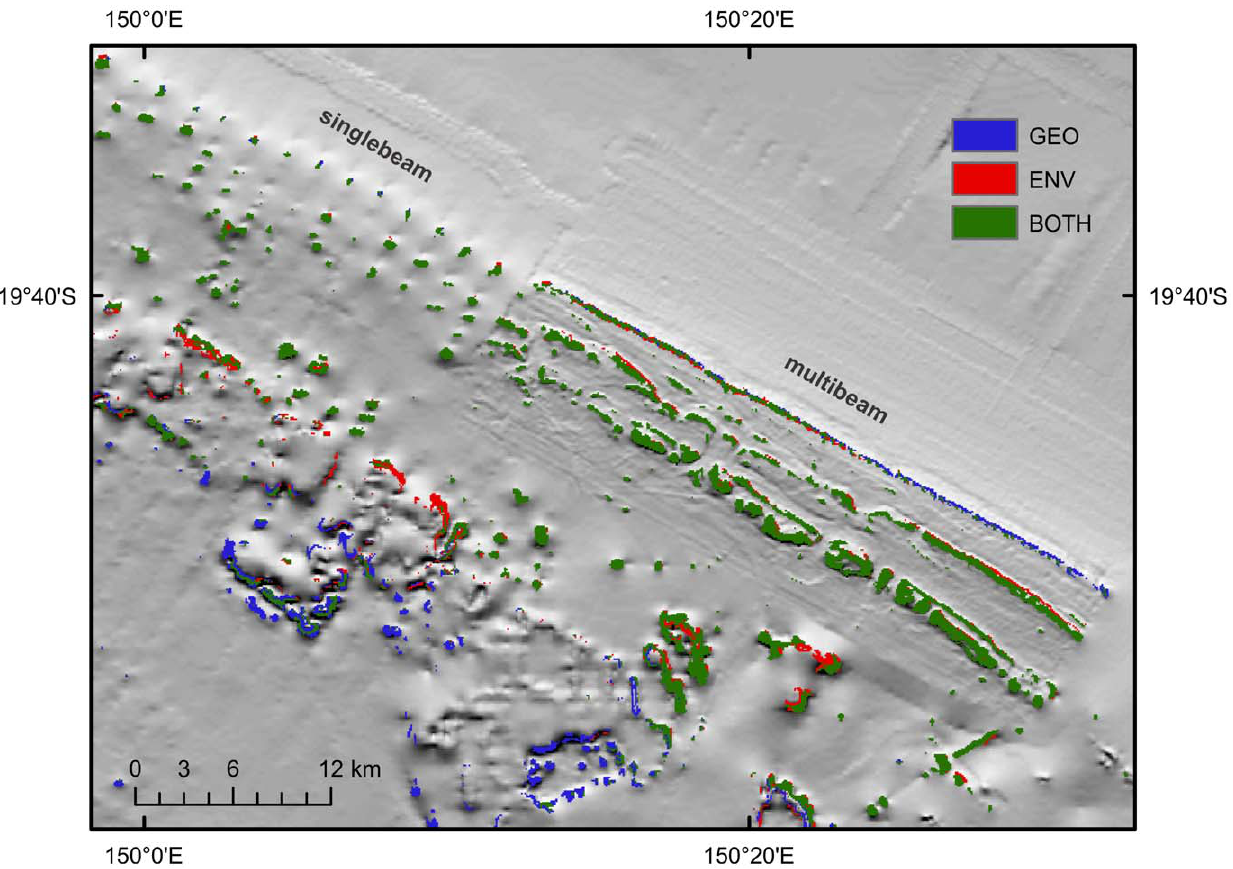
Figure 4. Predictions of phototroph communities in the Hydrographers Passage region, central Great Barrier Reef. GEO only and GEO-ENV both predicted suitable habitat along the outer-self, although model results were more accurate in areas with multibeam (right hand side) compared to singlebeam echosoundings (left). GEO also predicted higher habitat suitability on the deeper flanks of emergent reefs inside the GBR lagoon.